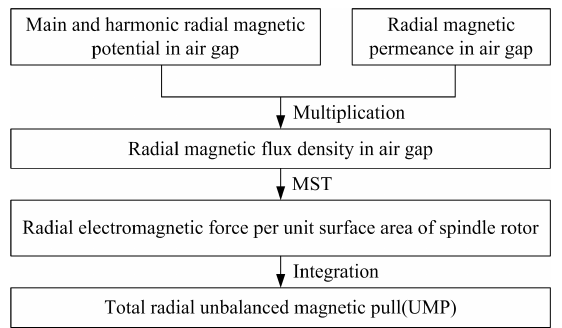
Figure 3. Electromagnetic force solving process of spindle motor.